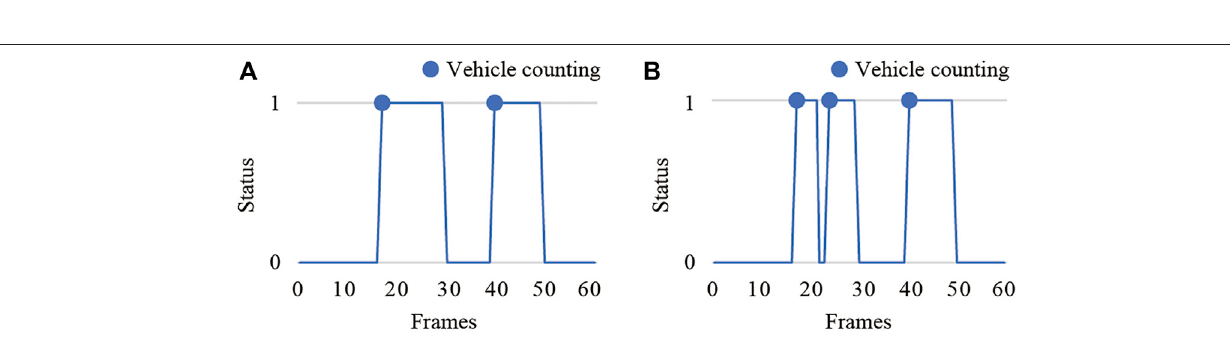
Frontiers in Physics |